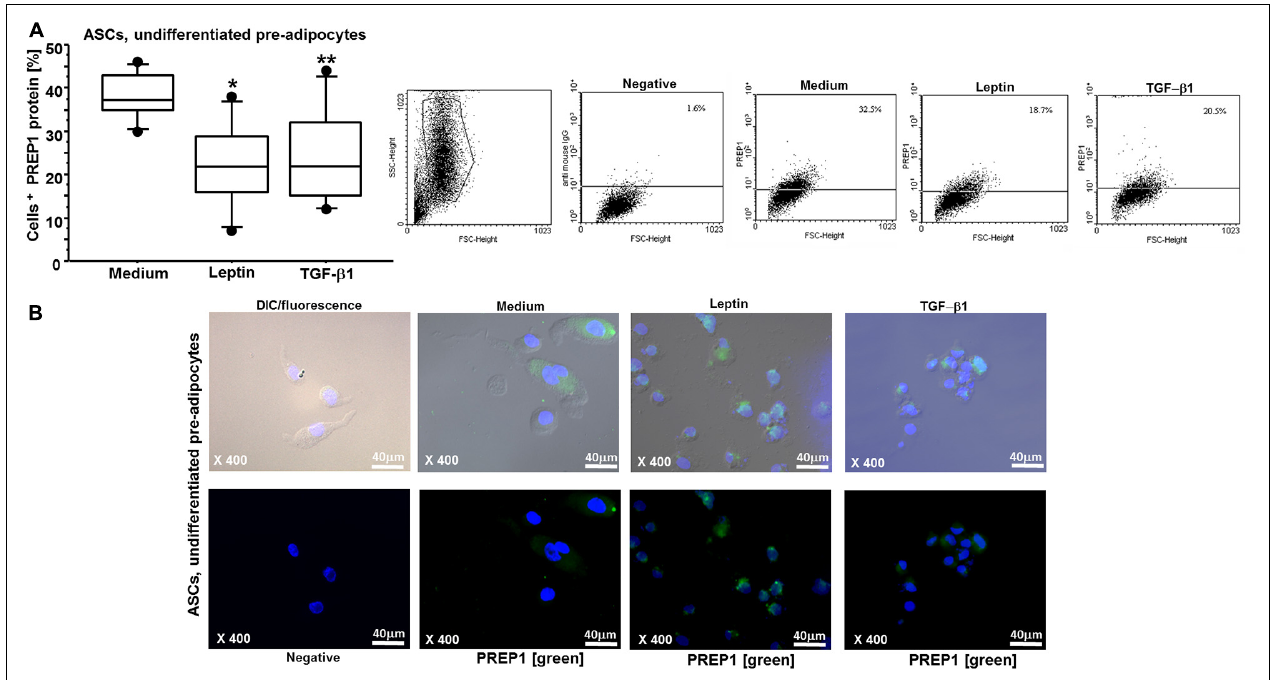
FIGURE 3 | (A) Flow cytometry analysis on ASCs for PREP1: both leptin (0.05 µ M) and TGF- β 1 (400 nM) significantly reduced PREP1 expression (* p = 0.0149 and ** p = 0.0318, respectively); the results are shown as box-plots with medians (lines inside the boxes), 25th and 75th percentiles (limits of boxes), and the 10th and 90th percentiles (whiskers) ( n = 7 experiments). Analysis of variance (ANOVA), Fisher’s PLSD. Right, representative examples of flow cytometric analysis. The numbers indicate the percentage of positive cells for PREP1. (B) Representative immunofluorescence for PREP1 (green) on ASCs is shown: higher, differential interference contrast (DIC-Nomarski) combined with DAPI and fluorescence; lower, DAPI with fluorescence (magnification at × 400, scale bar = 40 µ m). Axioskop-2-Zeiss microscope.